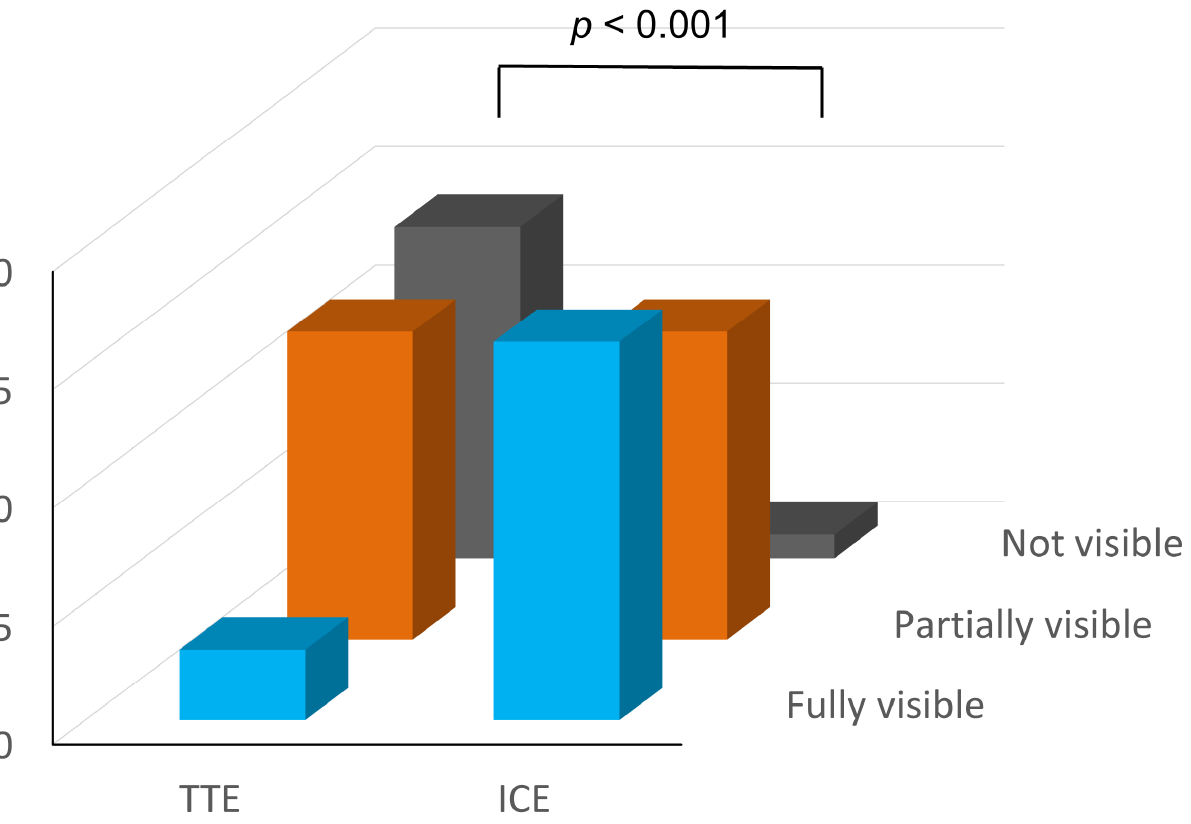
Figure 3. Visualization of the PV by TTE and ICE. The PV was not visible on TTE in nearly half of the patients. However, the PV was fully visible or partially visible on ICE in most cases (TTE vs. ICE, p < 0.001, Fisher’s exact test). TTE, transthoracic echocardiography; ICE, intracardiac echocar- diography.